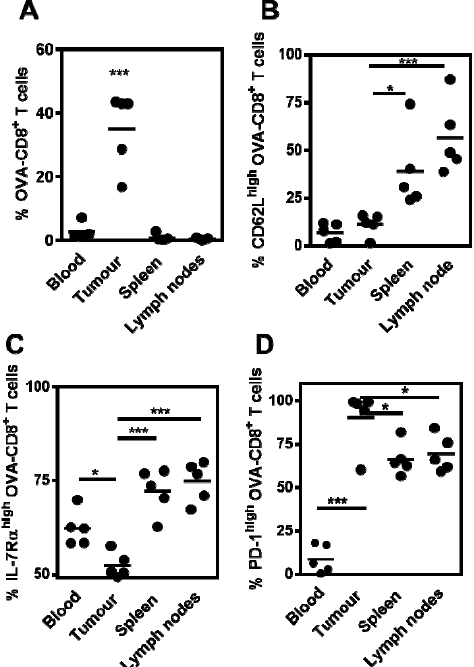
Figure 5. Phenotype and location of responding OVA 257–264 -specific CD8 + T cells in MS-OVA-vaccinated tumor bearing mice. C57BL/6 mice were given 10 6 B16-OVA tumor cells s.c. in the dorsal flank. Two days later, 10 5 OT.1 splenocytes were given intravenously. On days 3 and 8 after tumor injection, 20 µ g MS-OVA was injected s.c. at the base of the tail away from the tumor site. At days 33 and 37 post tumor injection, blood was collected and organs excised and processed to single cell suspensions for FACS analysis. The % of OVA-CD8 + T cells ( A ) and the frequency of CD62L high ( B ), IL-7R α high ( C ) or PD-1 high ( D ) was measured (mean ± SD, n = 5). One-way ANOVA and Dunnet’s post tests are